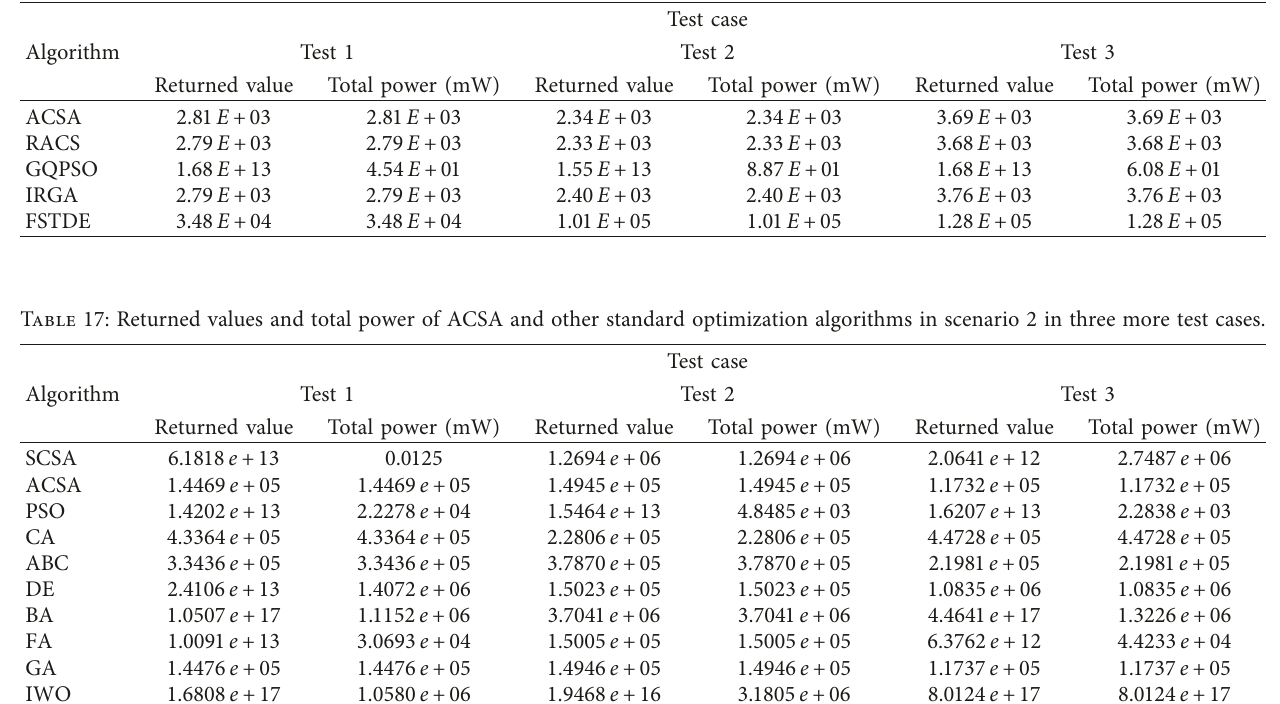
Table 16: Returned values and total power of ACSA and other advanced optimization algorithms in scenario 1 in three more test cases. Algorithm